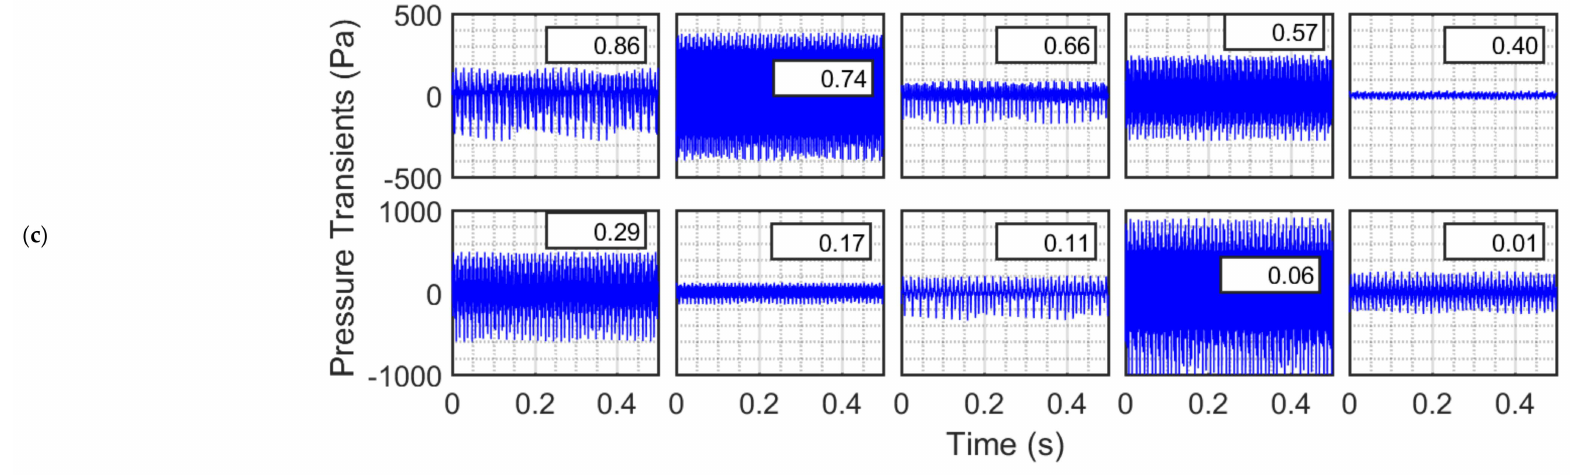
Figure 4. Local pressure transients in a closed empty column excited with sound waves of frequencies ( a ) 220, ( b ) 240, and ( c ) 360